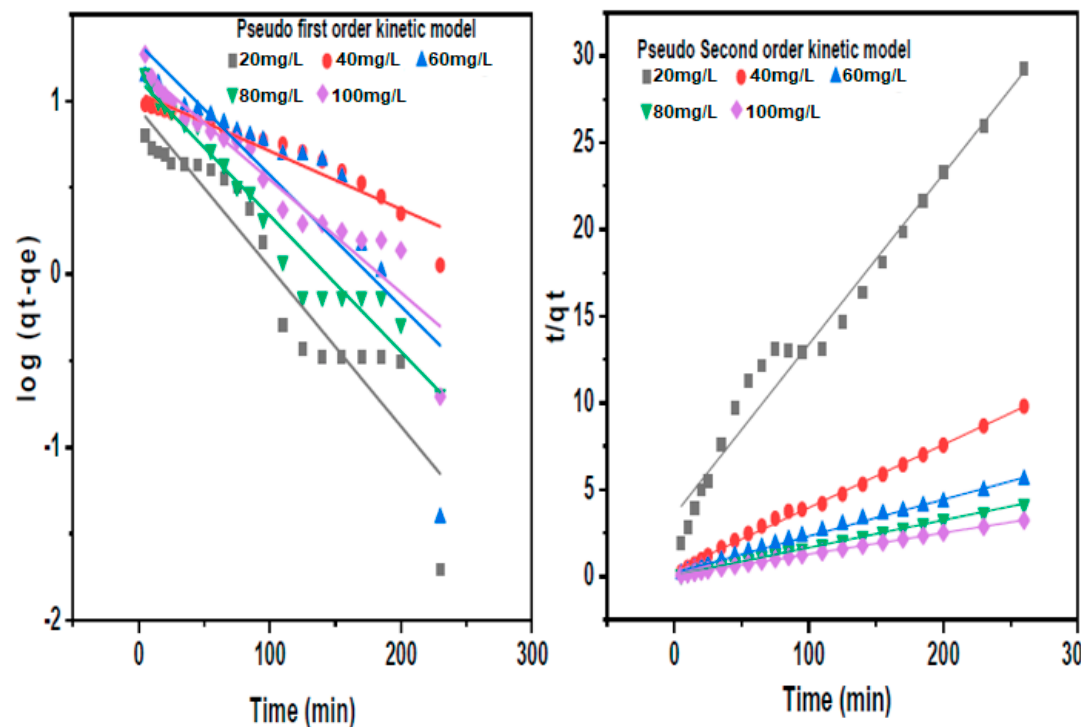
Figure 11. Initial Concentration of lead ions for first and second order kinetics.